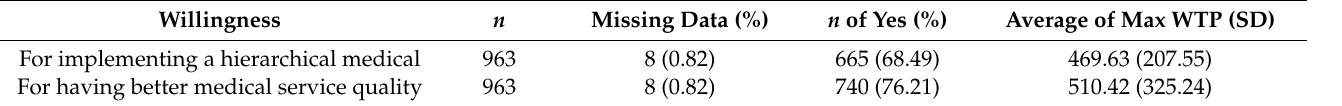
Table 4. The willingness to increasing outpatient copayment and average